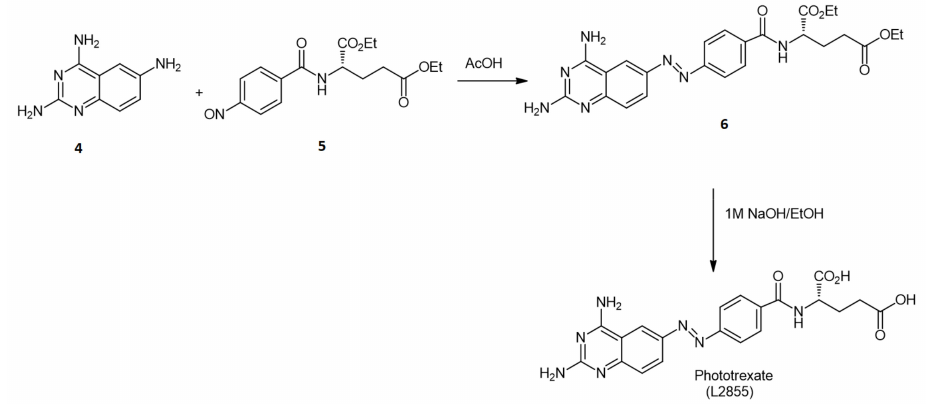
Figure 8. Schematic synthesis of